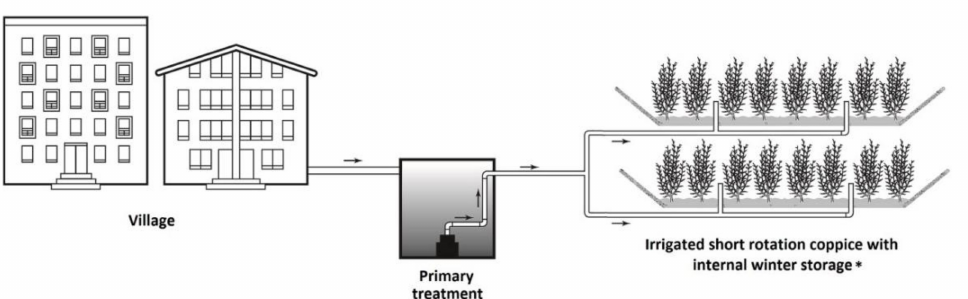
Figure 2. Option B: Operation of a wastewater irrigated short rotation coppice system with “internal winter storage” * The proposed internal winter storage is not sealed with a base liner but dyked along the